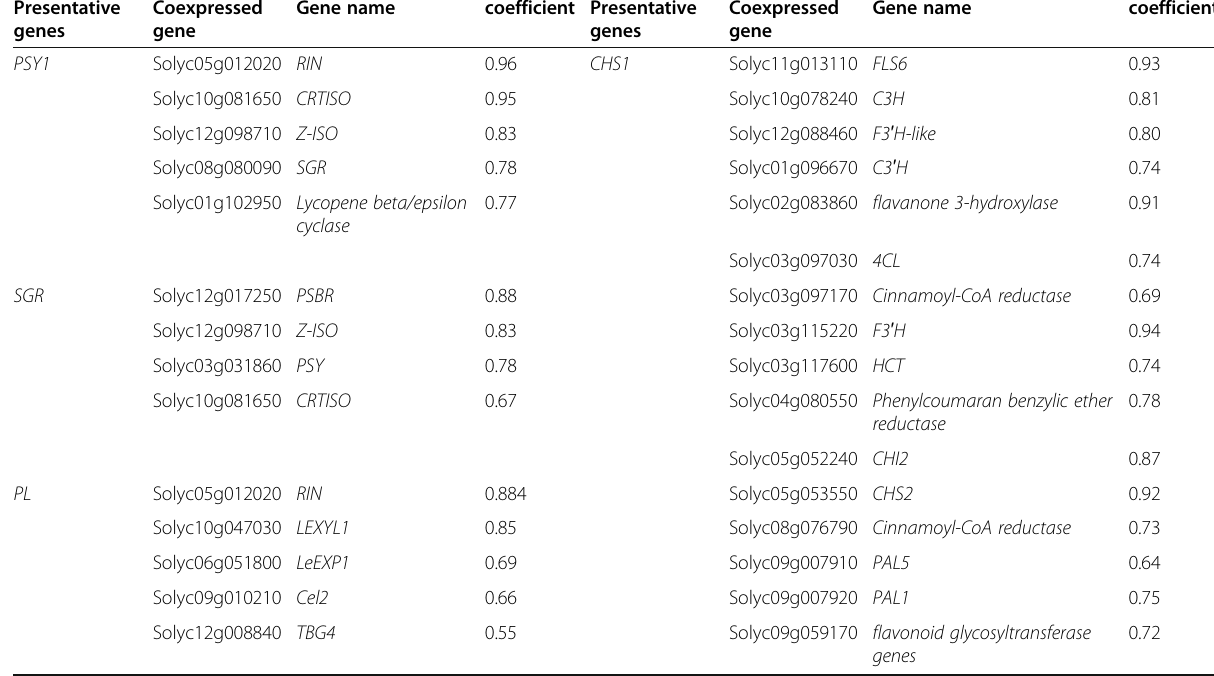
Table 2 Co-expression genes of presentative